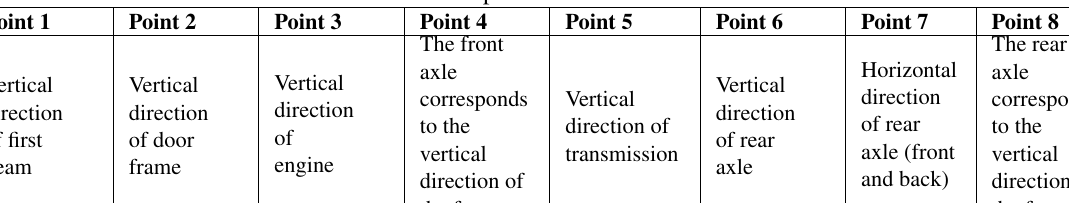
Table 1 Test point installation location.